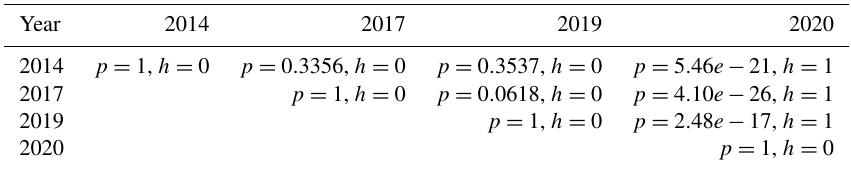
Table 4. Significance test, using the Mann–Whitney U test, for March in Europe.